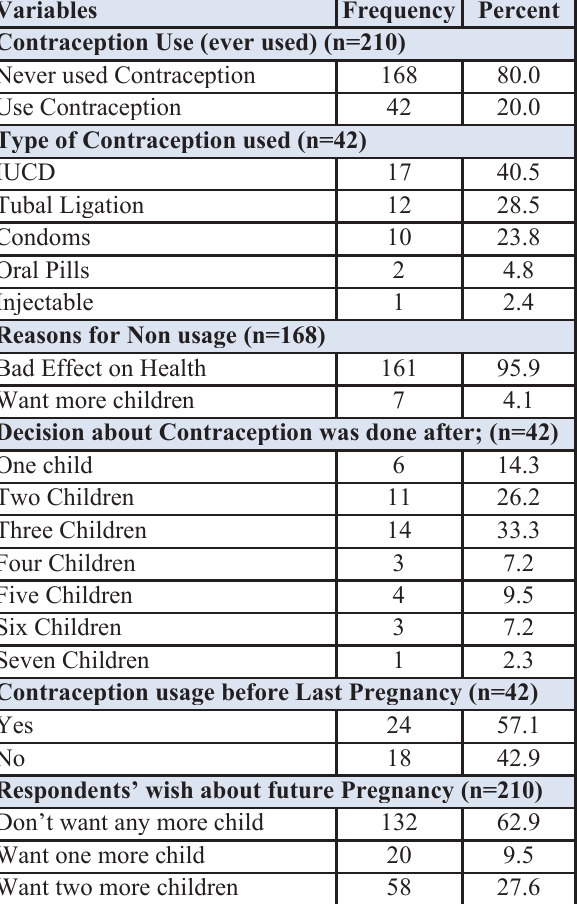
Table-2: Contraception-related practices among